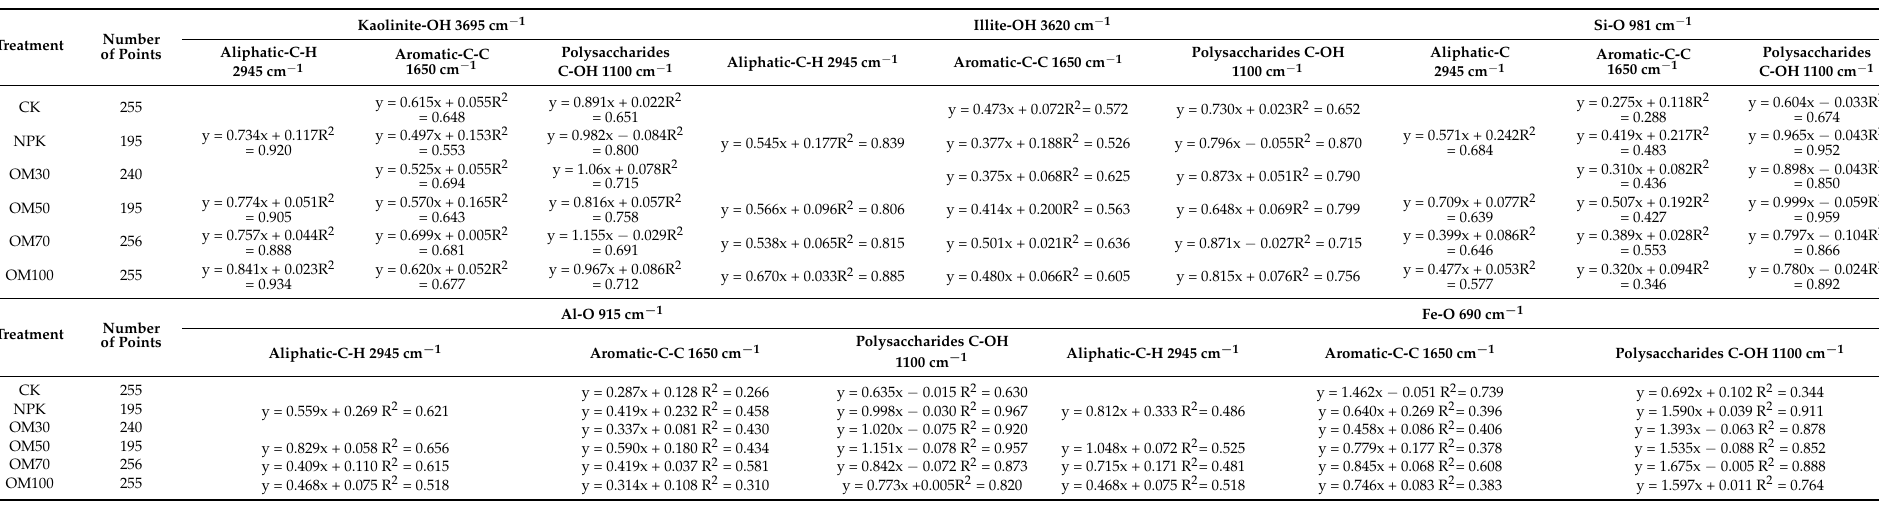
Table 3. The Correlation analysis between organic functional groups and minerals in soil aggregates as affected by different fertilizer treatments using